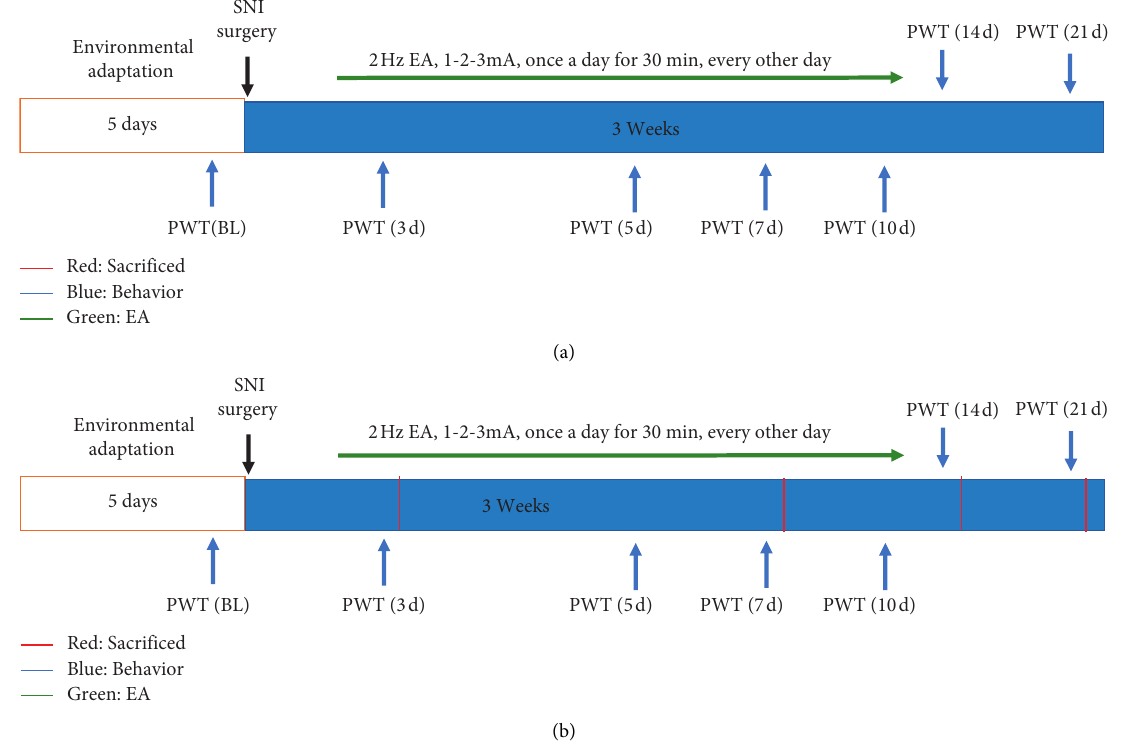
Figure 1: The schematic diagram of the experimental procedures. (a) The PWT was assessed following 2Hz EA stimulation on days 3, 5, 7, 10, 14, and 21 postSNI surgery. Rats were given 2Hz EA treatment with once every other day lasting for 21 days. (b) After 2Hz EA treatment with once every other day for 21 days, the PWTof rat was measured on days 3, 7, 14, and 21 post-SNI surgery, and the samples were collected from the L4-L6 segments of rat spinal cord for immunofluorescence staining, qRT-PCR, and western blot experiments,